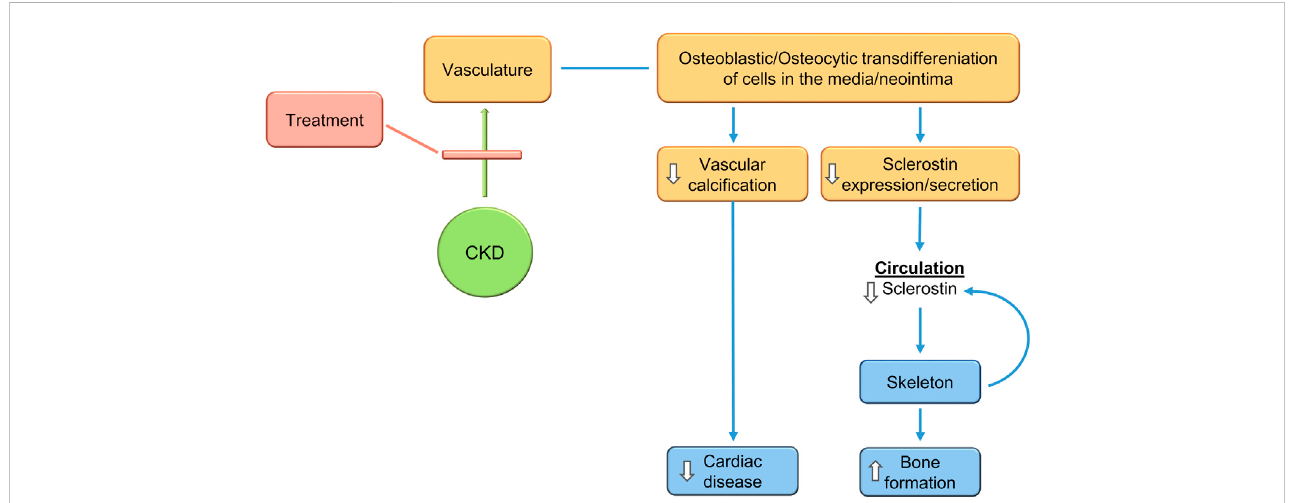
FIGURE 6 Treatment of the CKD-MBD inhibits VSMC transdifferentiation to osteocytic type cells, inhibiting vascular calci fi cation, decreasing sclerostin secretion, and stimulating bone formation. This would produce expected ef fi cacy in cardiovascular and skeletal outcomes. The changes in sclerostin levels during treatment make it a biomarker of progress.